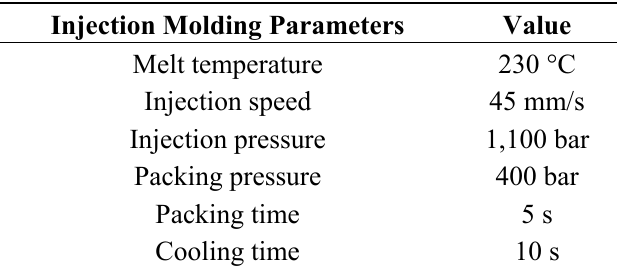
( b ) Table 1. Selected injection molding parameters with corresponding